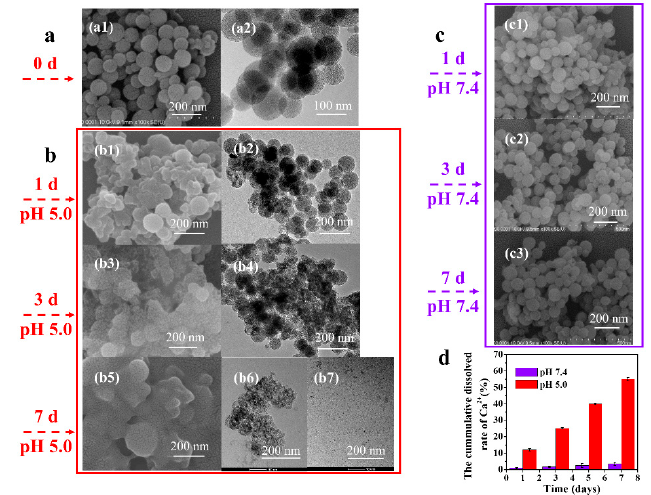
Figure 7. SEM ( a1 , b1 , b3 , b5 , c1 , c2 , c3 ) and TEM ( a2 , b2 , b4 , b6 , b7 ) images of MSCNs immersed in